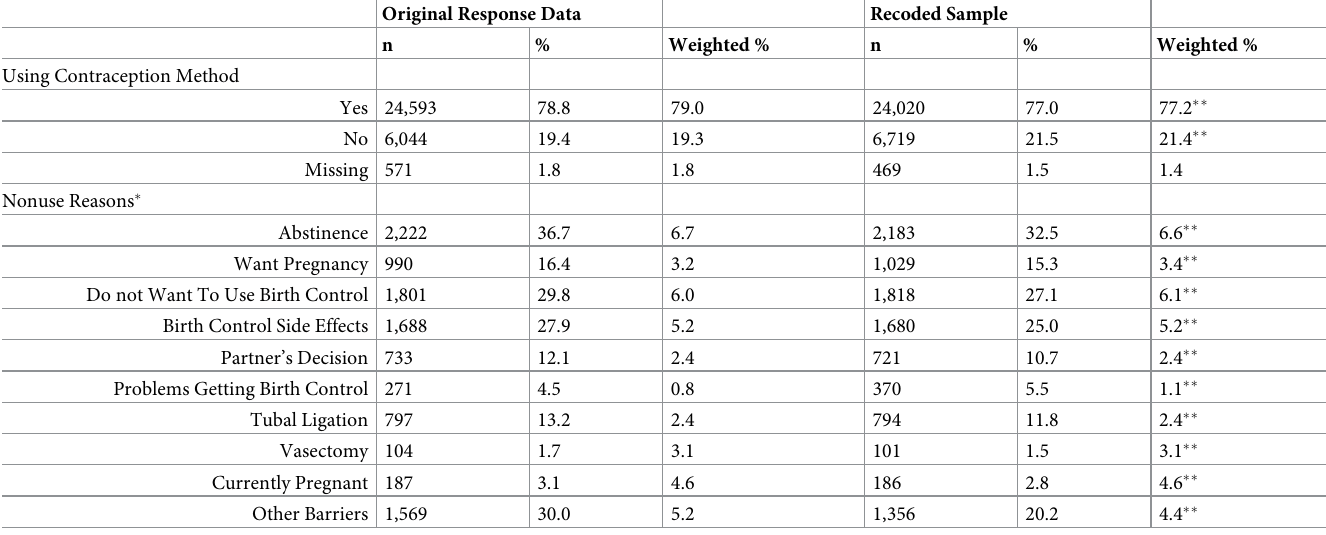
Table 1. Original and recoded postpartum contraception behavior ( n = 31,208) and reasons for nonuse among PRAMS Phase VII (2012)